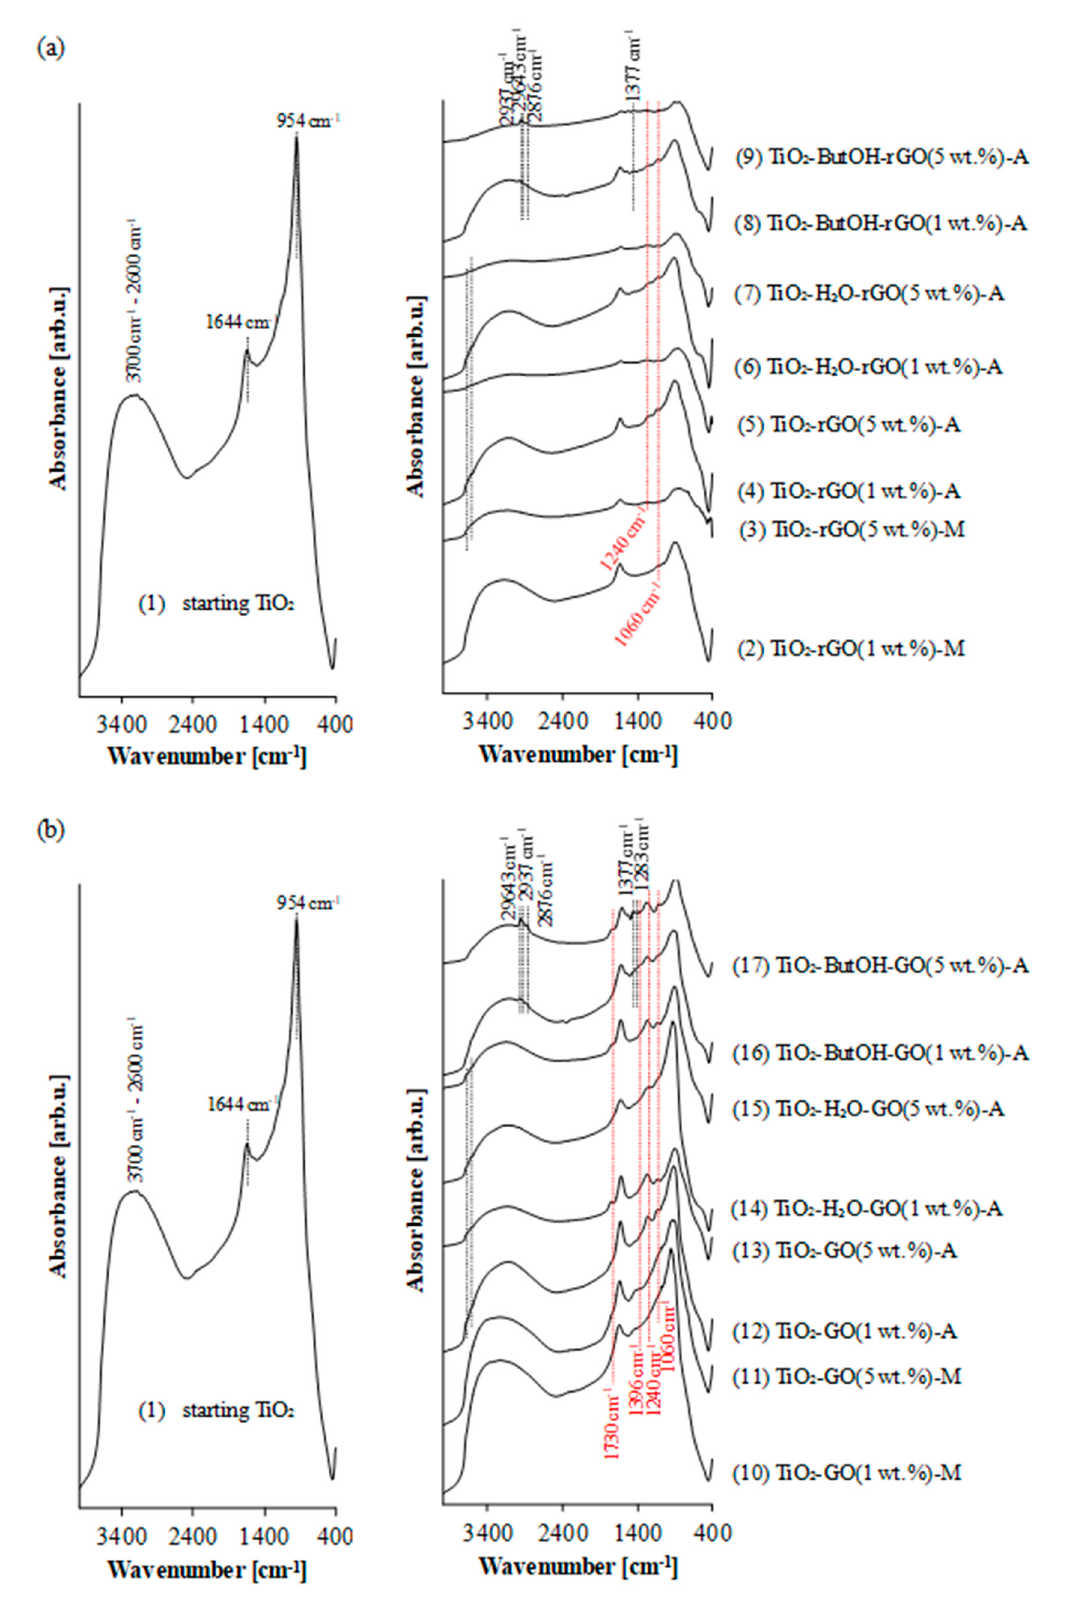
Figure 3. FTIR/DRS spectra of ( a ) TiO 2 -rGO and ( b ) TiO 2 -GO hybrid nanocomposite